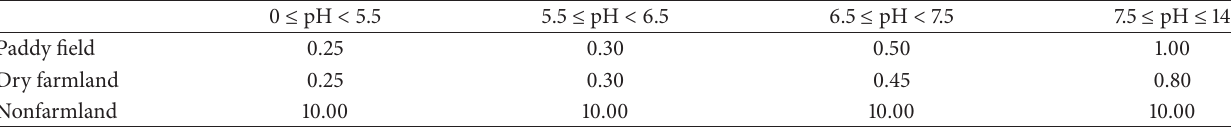
Table 1: The soil environmental quality standard II of China for Cd in soil (mg kg − 1 ).